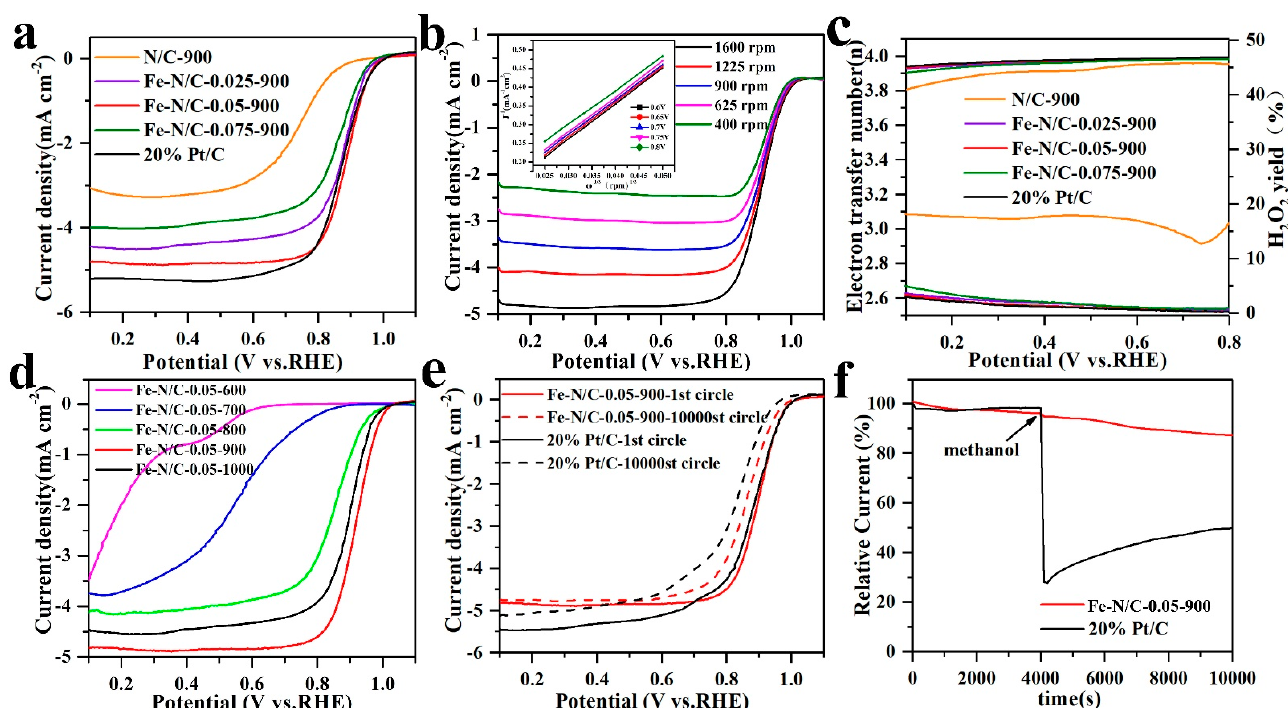
Figure 6. ( a ) LSV curves of Fe–N/C with different molar ratios of iron and 20% Pt/C in O 2 –saturated 0.1 M KOH, ( b ) LSV curves of Fe–N/C–0.05–900 obtained at different rotation rates and K–L plots, ( c ) transferred electron numbers and H 2 O 2 yield at different potentials, ( d ) ORR curves of the samples at different temperatures in 0.1 M KOH, ( e ) Stability tests of Fe–N/C-0.05-900 and 20% Pt/C catalysts: the LSV curves before and after 10,000 times CV. ( f ) Chronoamperometric responses of Fe–N/C-0.05-900 and 20% Pt/C, in which 3 M methanol was added at 4000 s.